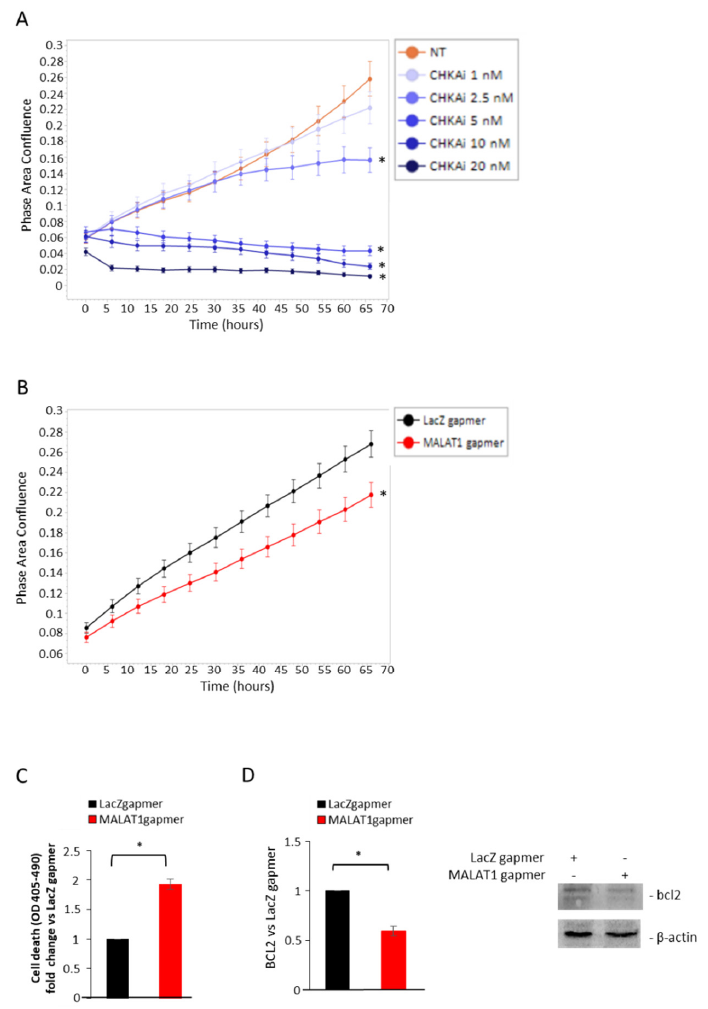
Figure 3. Effects on cell proliferation and cell death upon MALAT1 depletion or CHKA inhibitor treatment in LNCaP cells: ( A ) LNCaP cells were treated with CHKAi at the dose and time indicated and monitored using the IncuCyte live cell analysis system. Cell confluence was calculated from raw data images; data represent mean ± SEM of n = 2 independent experiments, each performed in quadruplicate. * p < 0.05 vs. NT. ( B ) Cell proliferation after MALAT1 gapmer delivery was monitored using the IncuCyte live cell analysis system. Cell confluence was calculated from raw data images; data represent mean ± SEM of n = 2 independent experiments, each performed in triplicate. * p < 0.05 vs. LacZgapmer. ( C ) Apoptosis induction by MALAT1 depletion (96 h) evaluated using Cell Death Detection ELISA Kit (Roche, Palo Alto, CA, USA) as described in Methods. Data are expressed as fold change vs. LacZ gapmer, representing the mean ± SEM of three independent experiments. * p < 0.05 MALAT1gapmer vs. LacZgapmer. ( D ) Representative blc2 western blot and densitometry analysis after MALAT1 depletion (72 h). β -actin was used as a loading control. Data are represented as mean of fold change vs. LacZgapmer ± SEM ( n = 3). * p < 0.05 MALAT1 gapmer vs. LacZ